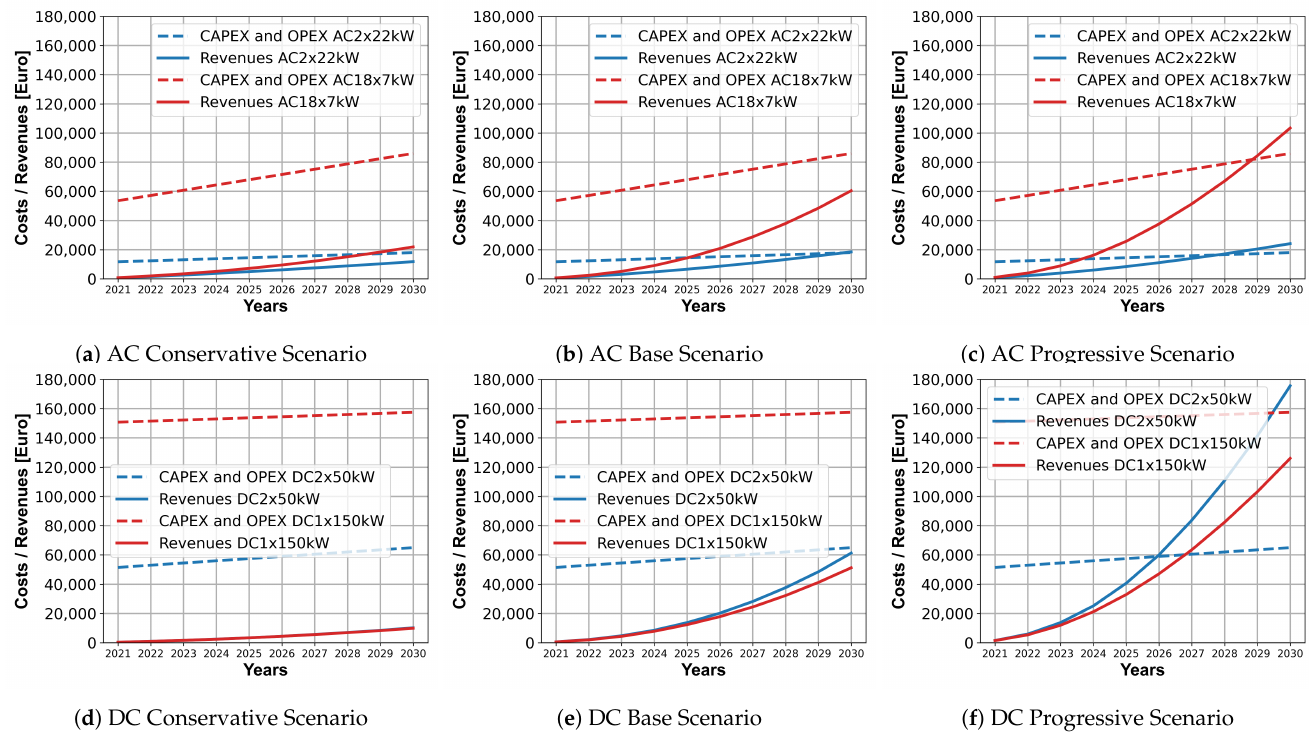
Figure 13. Economic result for the investigated charging